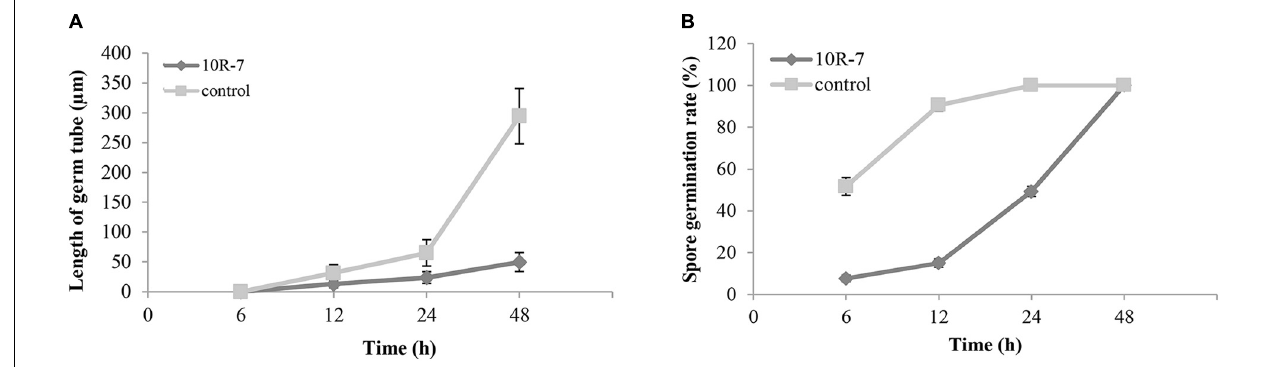
FIGURE 4 | Effect of culture filtrates of F. proliferatum 10R-7 (the concentration is 10%) on germ tube elongation (A) and spore germination (B) of V. dahliae .